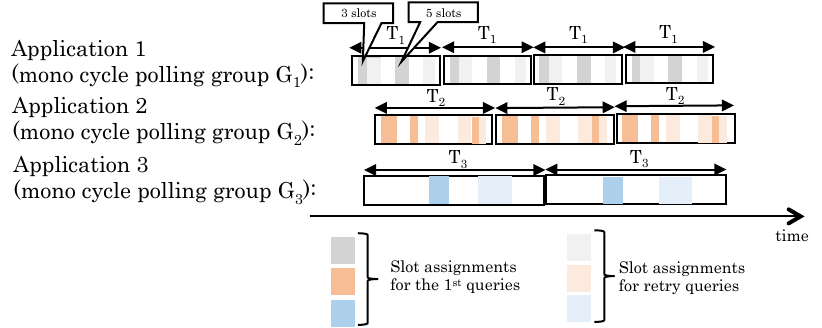
Figure 2. An example of multicycle polling